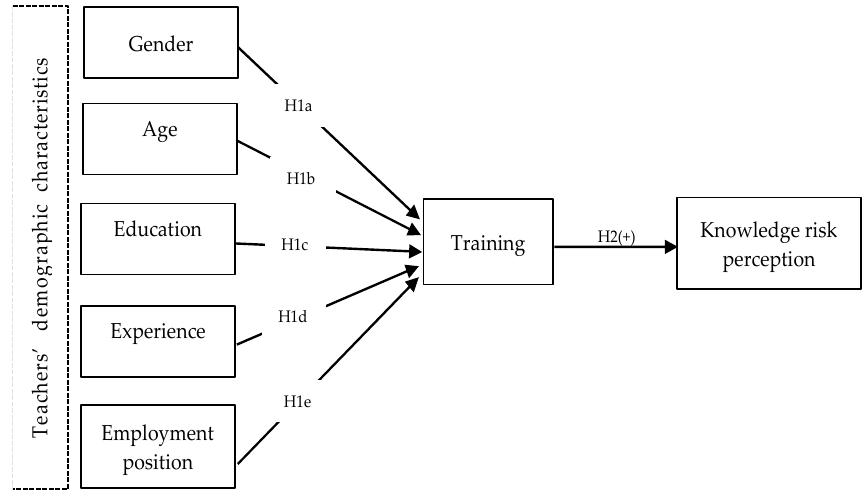
Figure 1. The conceptual framework. Source: Authors’ conceptualization.